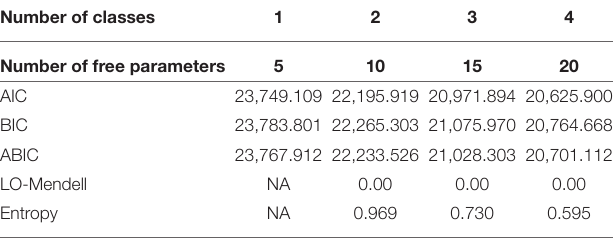
TABLE 1 | Fit indices for TIC-MM; intrinsic motivation.